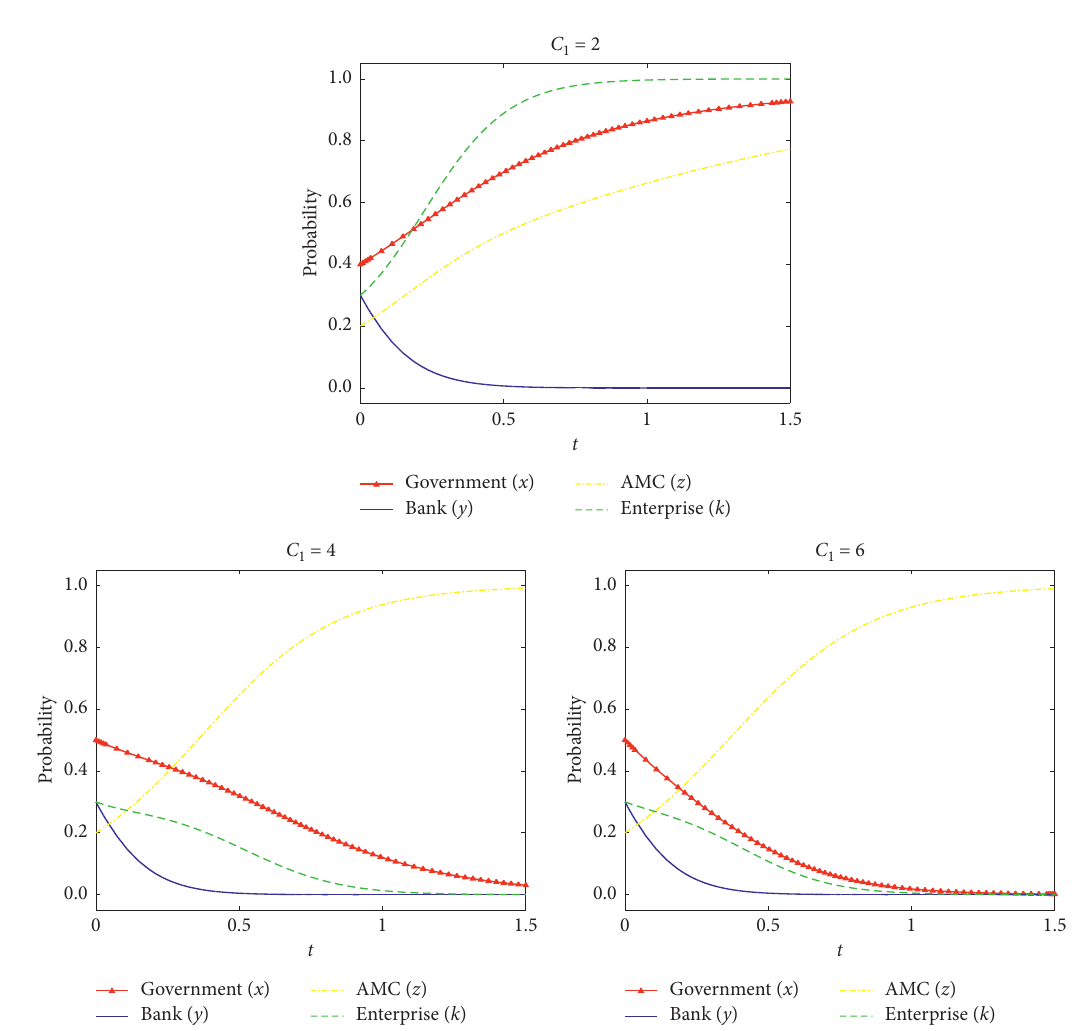
Figure 5: The impact of government support costs on the evolution of various parties’